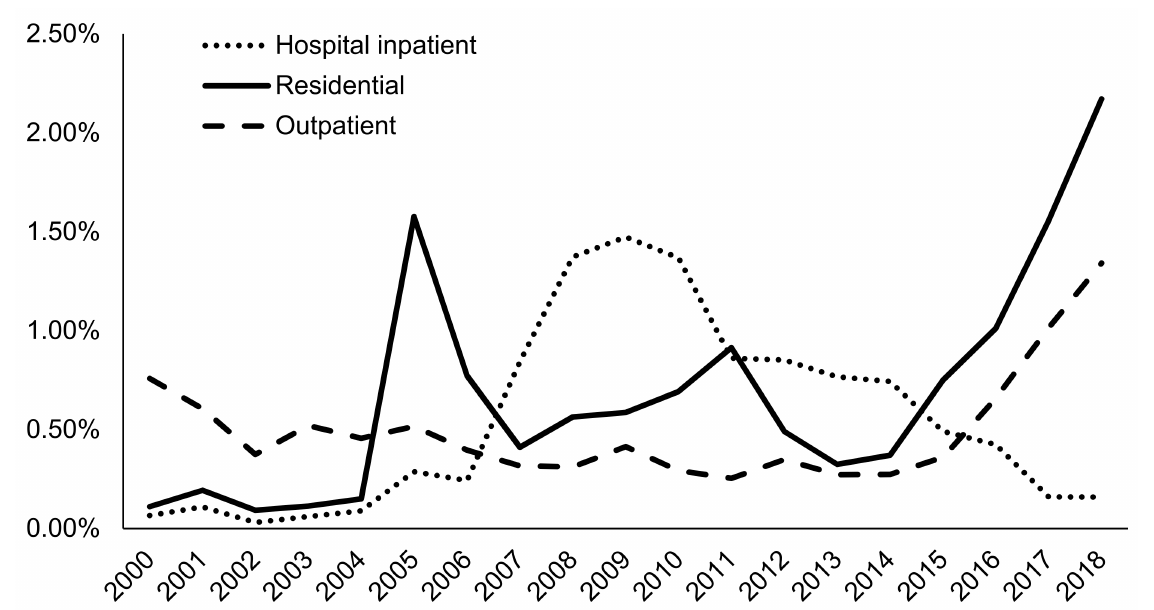
Figure 10. Prevalence of naltrexone treatment prescribed in alcohol use disorder (AUD) admissions from 2000–2018 by treatment service setting at admission using TEDS-A data. Temporal trends were significant by the Cochran–Armitage trend test ( p < 0.0001). Hospital inpatient (detox, 24-h, hospital inpatient; rehab/residential, hospital non-detox); residential (rehab/residential, short term and long term; detox, 24-h, free-standing residential); outpatient (ambulatory, including intensive outpatient, non-intensive outpatient, and